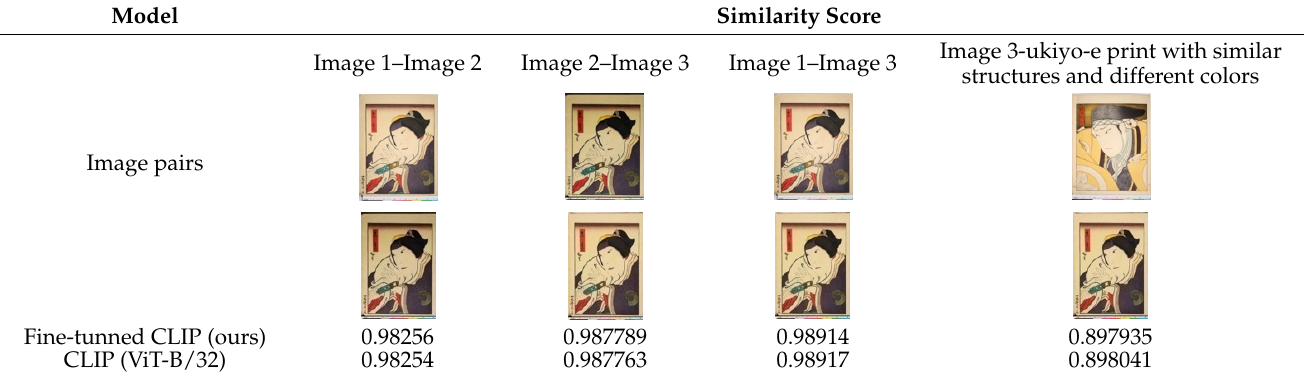
Table 11. Similarity score calculation on the same ukiyo-e print digitized at the different institutions.